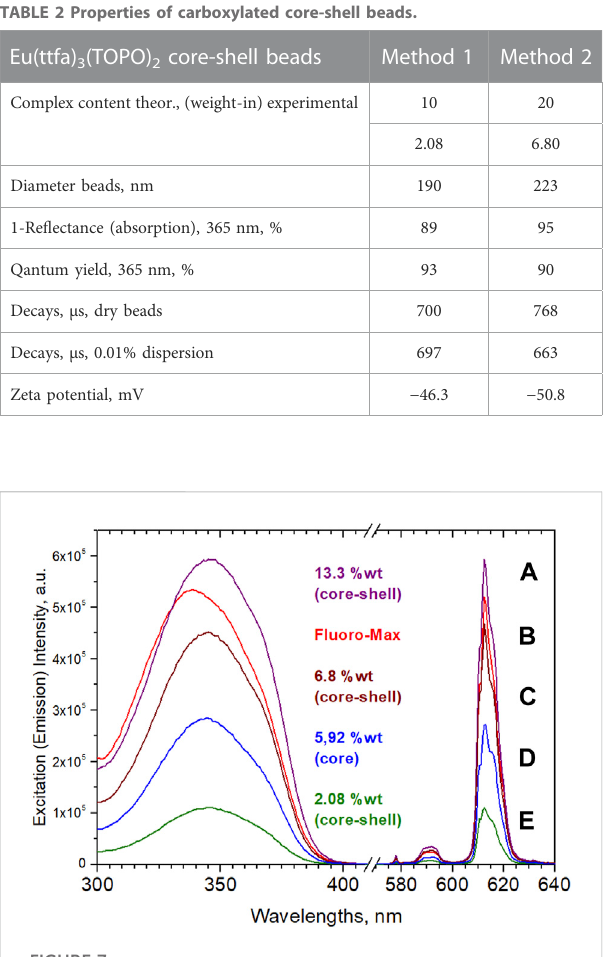
Excitation and emission of aqueous 0.0025% wt dispersions. Note that (D) , “ naked ” , and (C) , core-shell, have practically the same complexcontents.Particlesizeswere190 nm (E) ,150 nm (D) ,223 nm (C) , 201 nm (B) ; agglomerated-bimodal 334 nm and 147 nm (A) . (B) is the producer ’ s value for